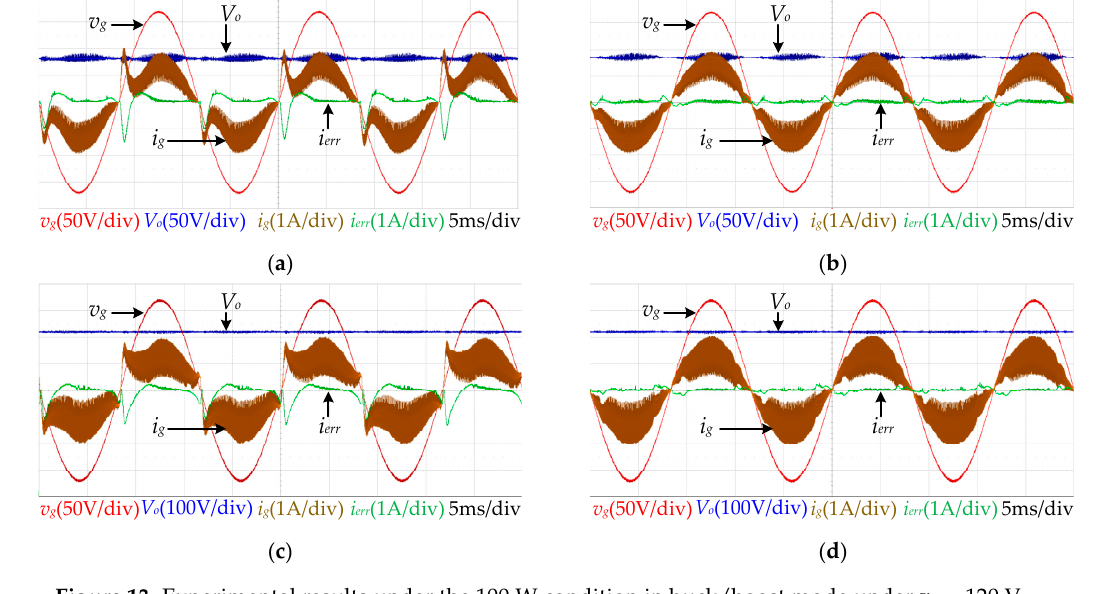
Figure 13. Experimental results under the 100 W condition in buck/boost mode under v g = 120 V rms , V o = 80 V(buck)/ V o = 220 V(boost): ( a ) without the repetitive controller in buck mode; ( b ) with the repetitive controller in buck mode; ( c ) without the repetitive controller in boost mode; ( d ) with the repetitive controller in boost mode.